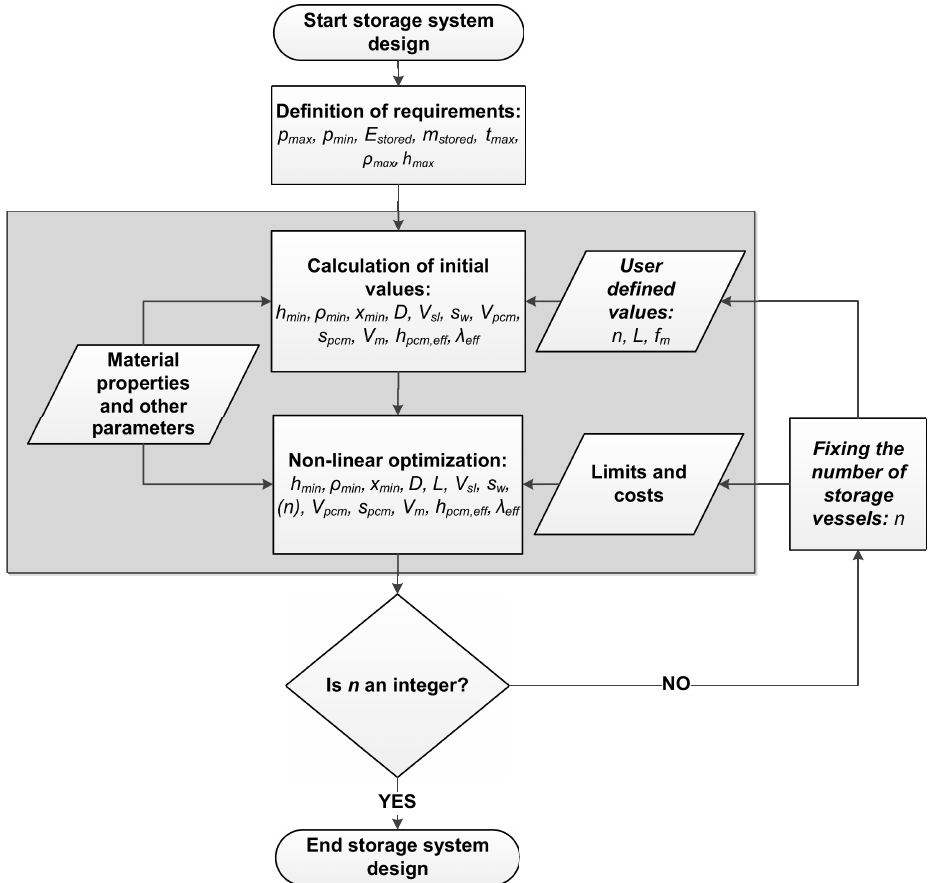
Figure 2. Design procedure for the hybrid storage